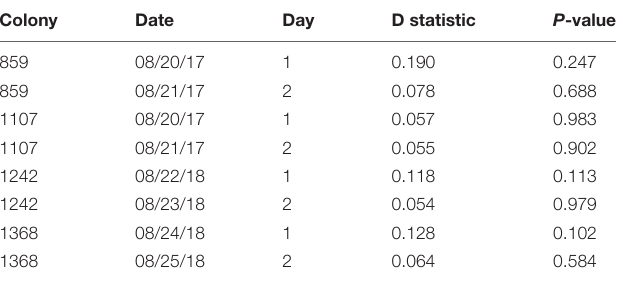
TABLE 2 | Results from two-sample Kolmogorov-Smirnov tests, comparing the distributions of marked ants and of all ants of outgoing foragers per minute as a function of humidity ( Figure 2 ).